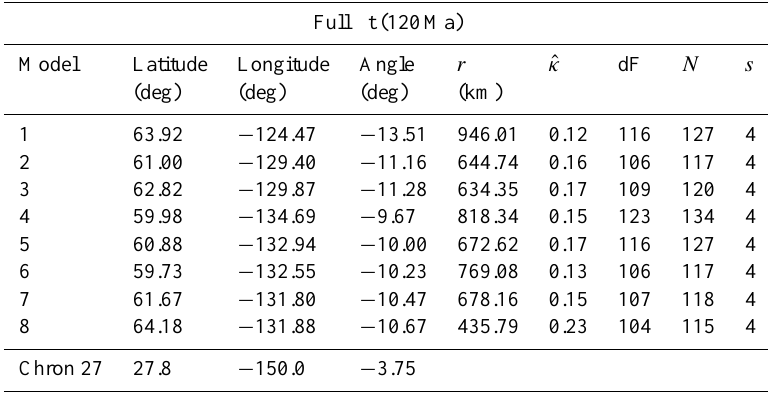
Table 1. Full-fit rotation parameters for alternative models of Greenland relative to North America (fixed) discussed in this paper. The chron 27 pole of rotation derived from Oakey and Chalmers (2012) has also been represented.